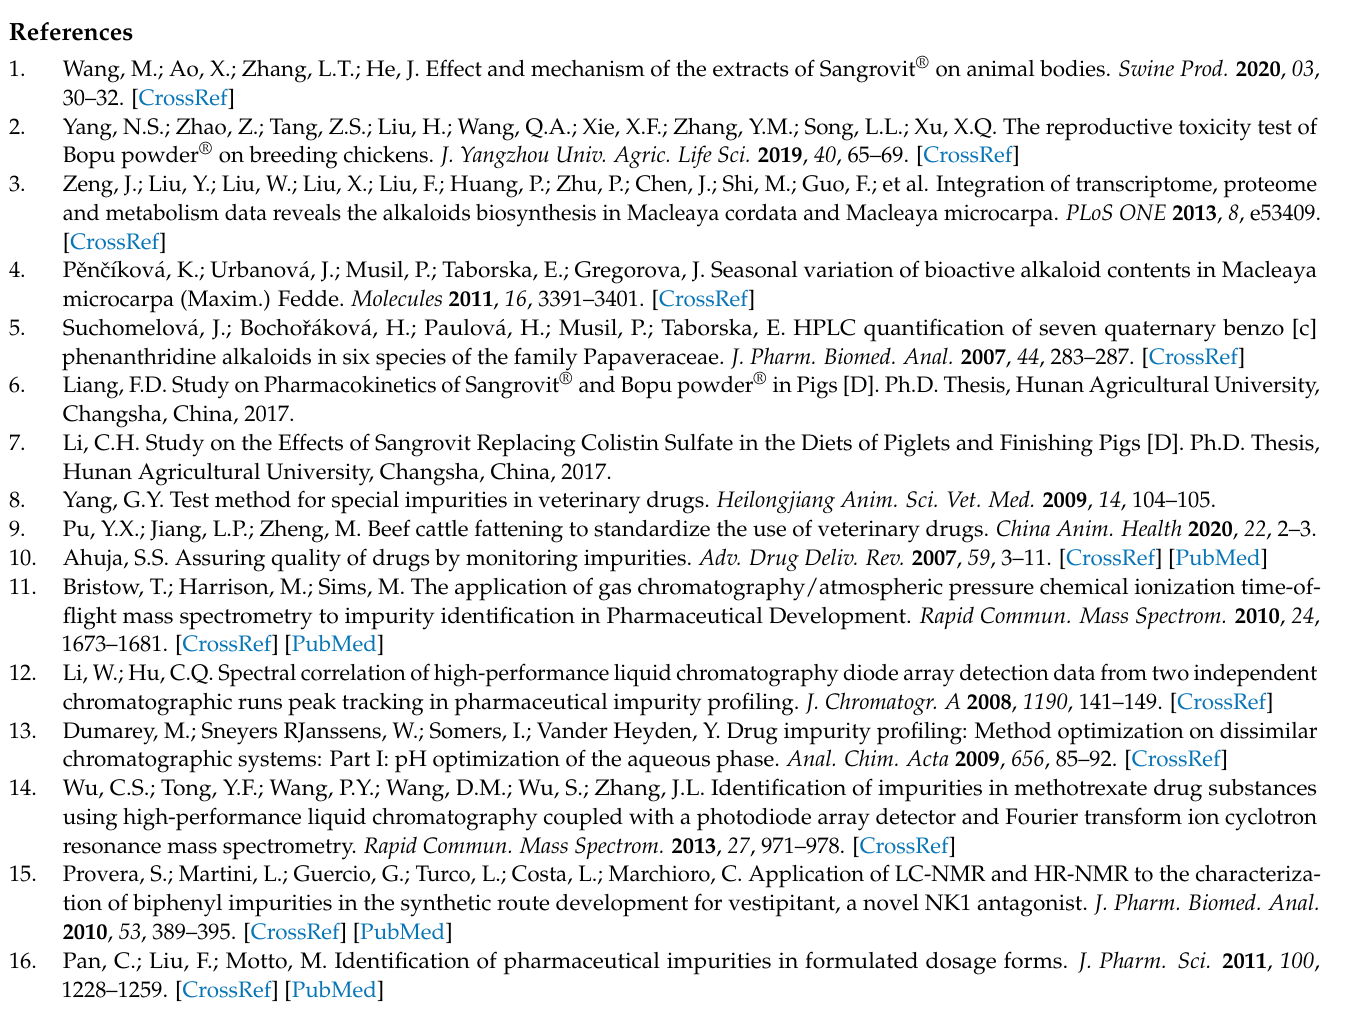
Table S1: The summarized alkaloids in genus Macleaya ( Macleaya cordata and Macleaya microcarpa). Table S2: Protoberberine-type alkaloids skeleton, exact theoretical masses ([M + H] + ), substituent groups (88 theoretical accurate m/z